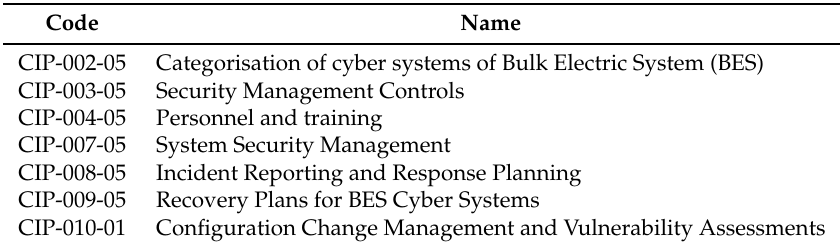
Table 2. North American Reliability Corporation (NERC) Critical Infrastructure Protection (CIP) cyber security maintenance